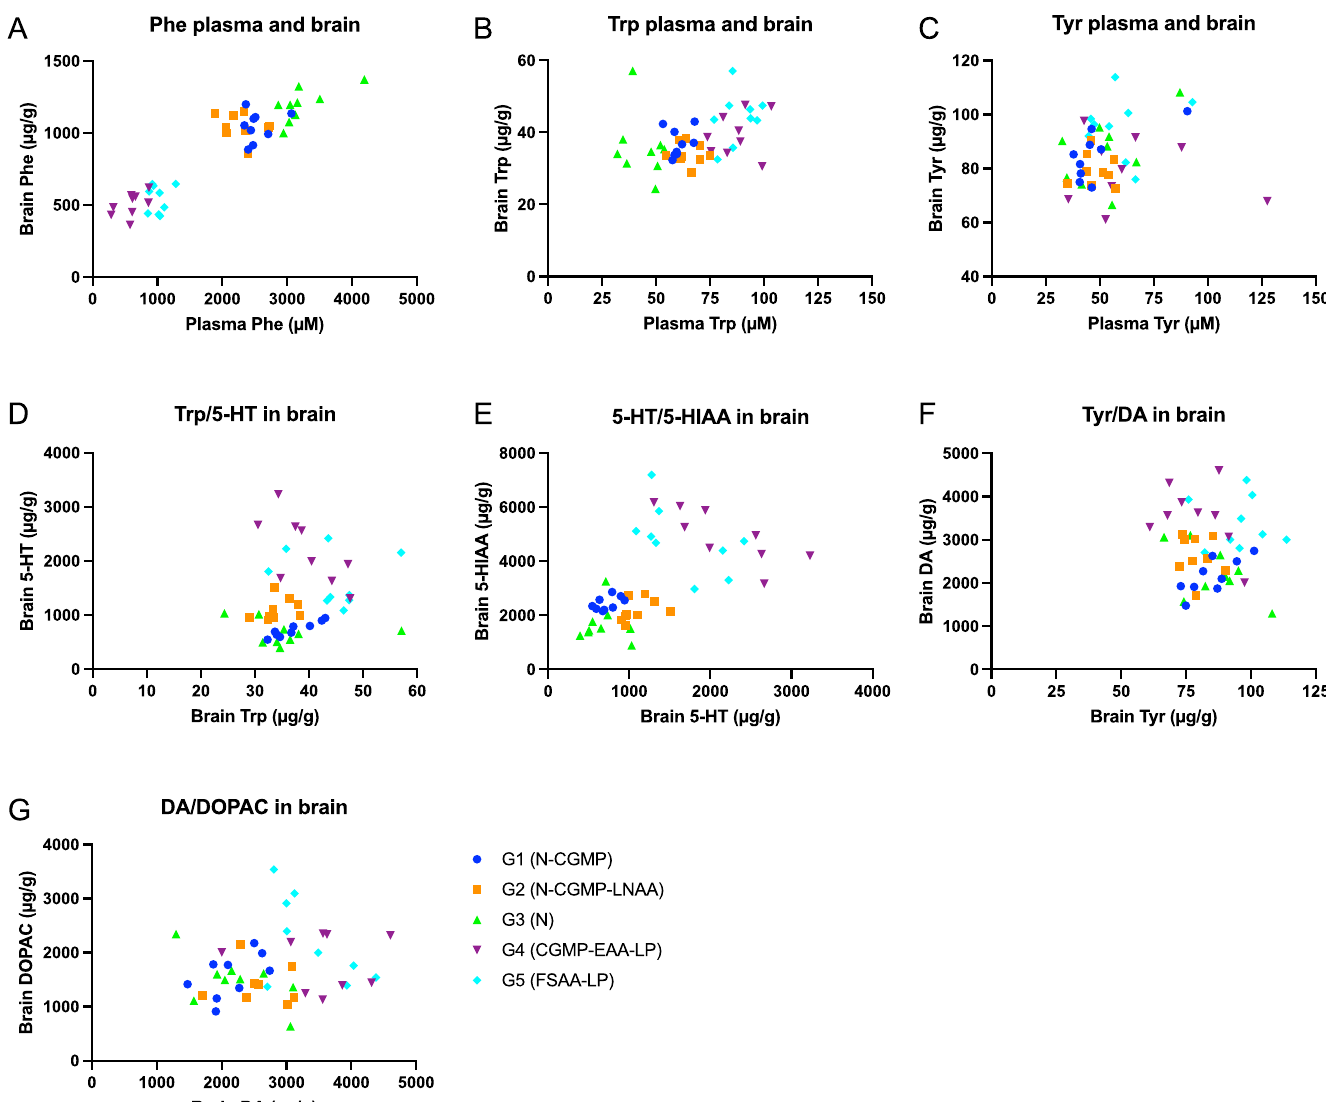
Fig 7. Correlation of the content of Phe, Tyr, Trp (plasma and brain) and the neurotransmitters, 5-HT, DA, and their metabolites 5-HIAA, DOPAC in the total brain. Group 1–5 represent: G1(N-CGMP), G2 (N-CGMP-LNAA), G3 (N), G4 (CGMP-EAA-LP) and G5 (FSAA-LP).